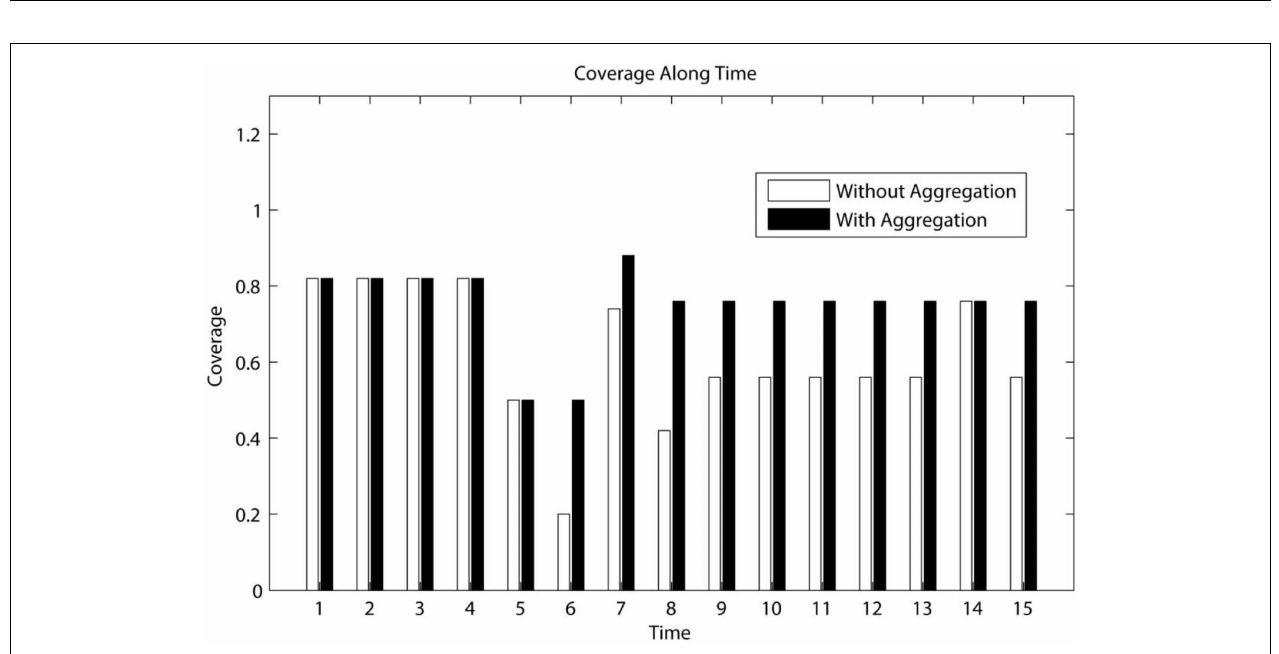
FIGURE 9 | Demonstration of coverage percentage . Black bars: coverage of aggregated prediction.White bars: coverage of prediction with only UAVs’ data.